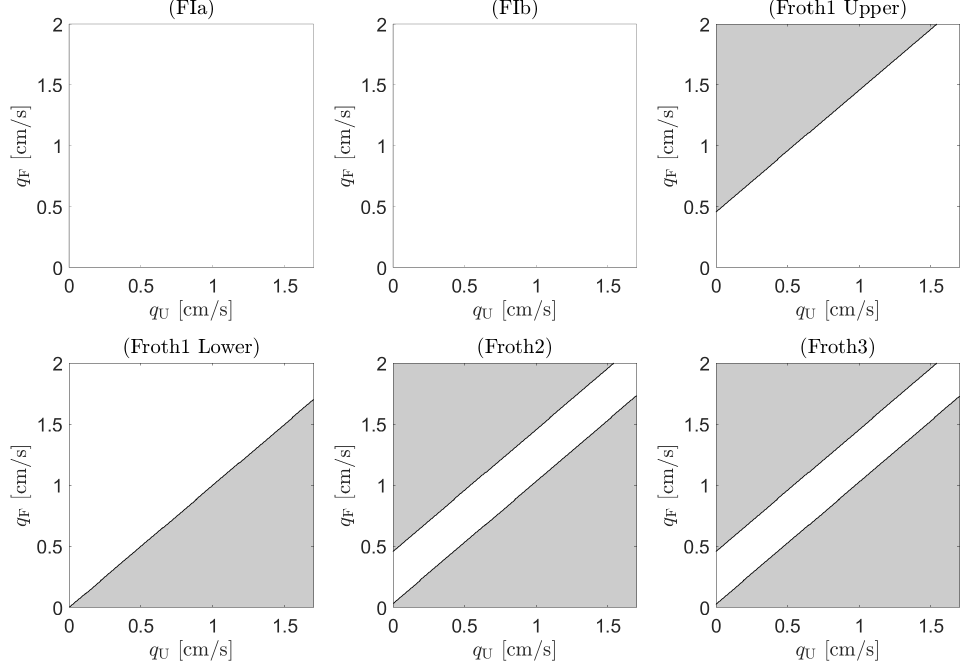
Figure 8. Operating charts showing the theoretical conditions for a steady-state with a froth present in the upper part of the flotation column for the first steady-state experiment. A white region means that the condition is satisfied. The superposition of all these charts results in a white strip, which can be seen in the ( q U , q F ) -plane in Figure 9 (Experiment 1). The labels (FIa), (FIb), (Froth1), (Froth2), and (Froth3) correspond the notation in [19] and to the respective inequalities (19), (20), (25), (26), and (27) in the present